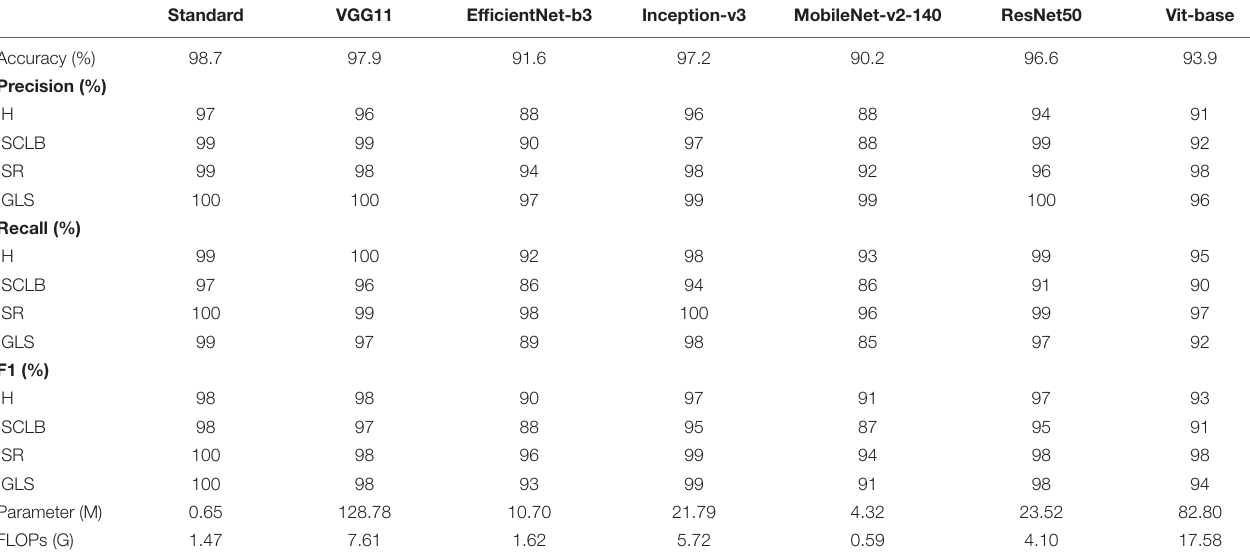
FIGURE 6 | Accuracy curve and loss curve of validation set of all models in this article (i.e., Model-1 and Model-2). TABLE 2 | Comparison between the standard model and the other mainstream